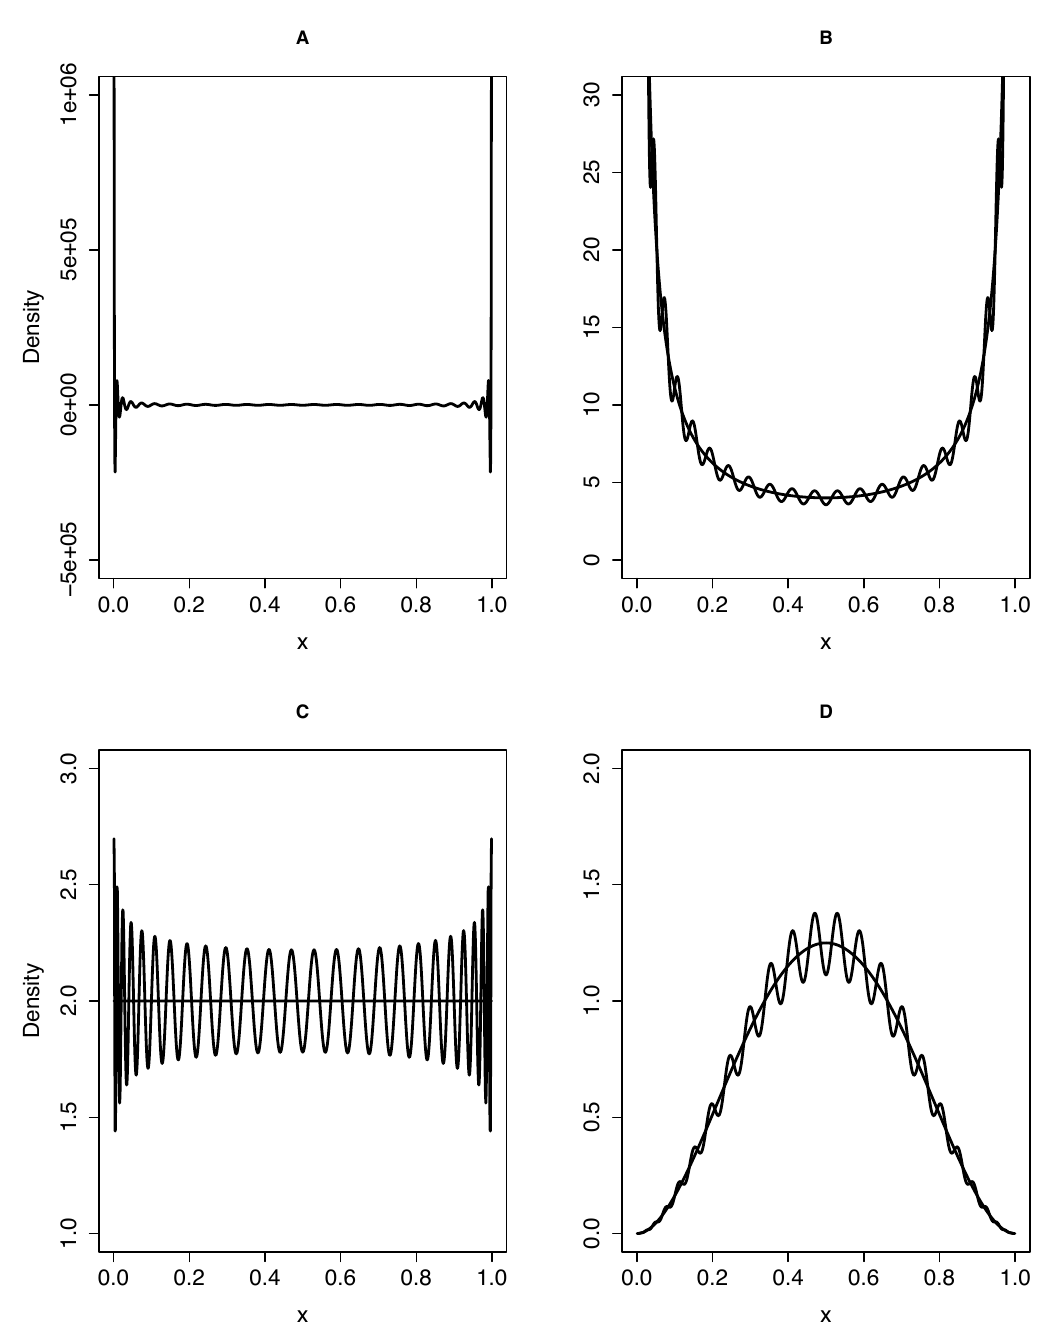
Figure 1. Approximate densities using the Gegenbauer polynomial expansion with terms up to n = 52. ( A ) Approximation to point masses at both boundaries, but without mass in the interior region; ( B ) approximation to the equilibrium improper density overlying the function x − 1 ( 1 − x ) − 1 ; ( C ) approximation to the joint posterior distribution for a sample with y = 1, M = 1 overlying the joint distribution 2 x 1 − 1 ( 1 − x ) 1 − 1 ; ( D ) approximation to the joint posterior distribution for a sample with ) x 3 − 1 ( 1 − x ) 3 − 1 y = 3, M = 6 overlying the joint distribution ( 6 3